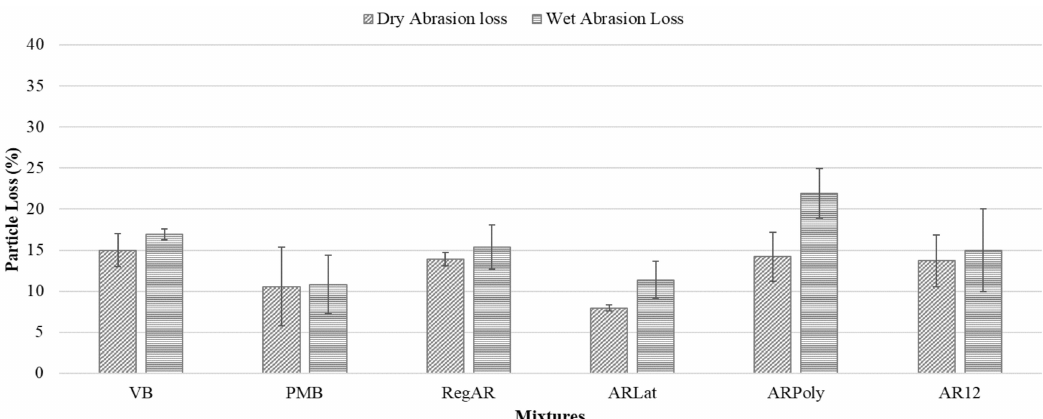
Figure 4. Particle loss by Cantabro test, error bars indicate the standard deviation about the